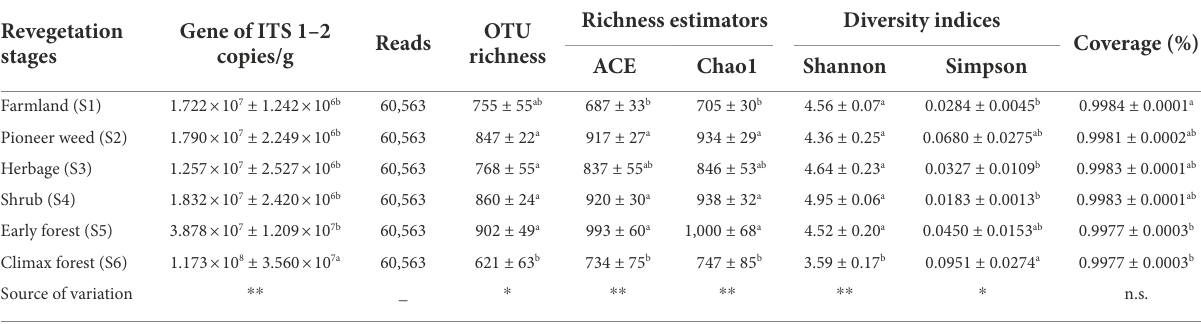
TABLE 1 Number of sequences analyzed, observed soil (0–20 cm depth) fungal community abundance (fungal ITS gene copies per gram of soil), richness and diversity indices (mean ± SE, n = 4) during various revegetation stages in the Loess Plateau of China, obtained for clustering at 97%